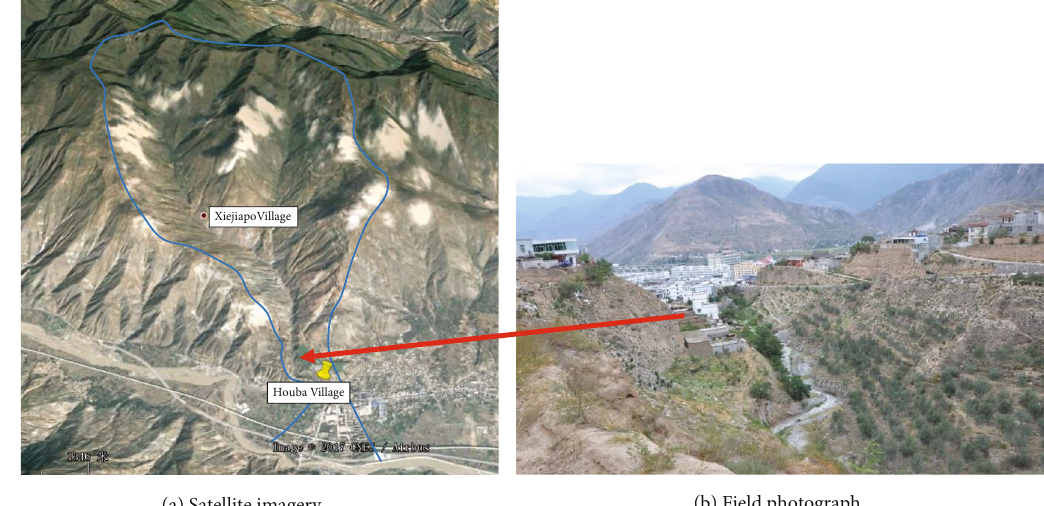
Figure 1: Topography of Niwan gully.